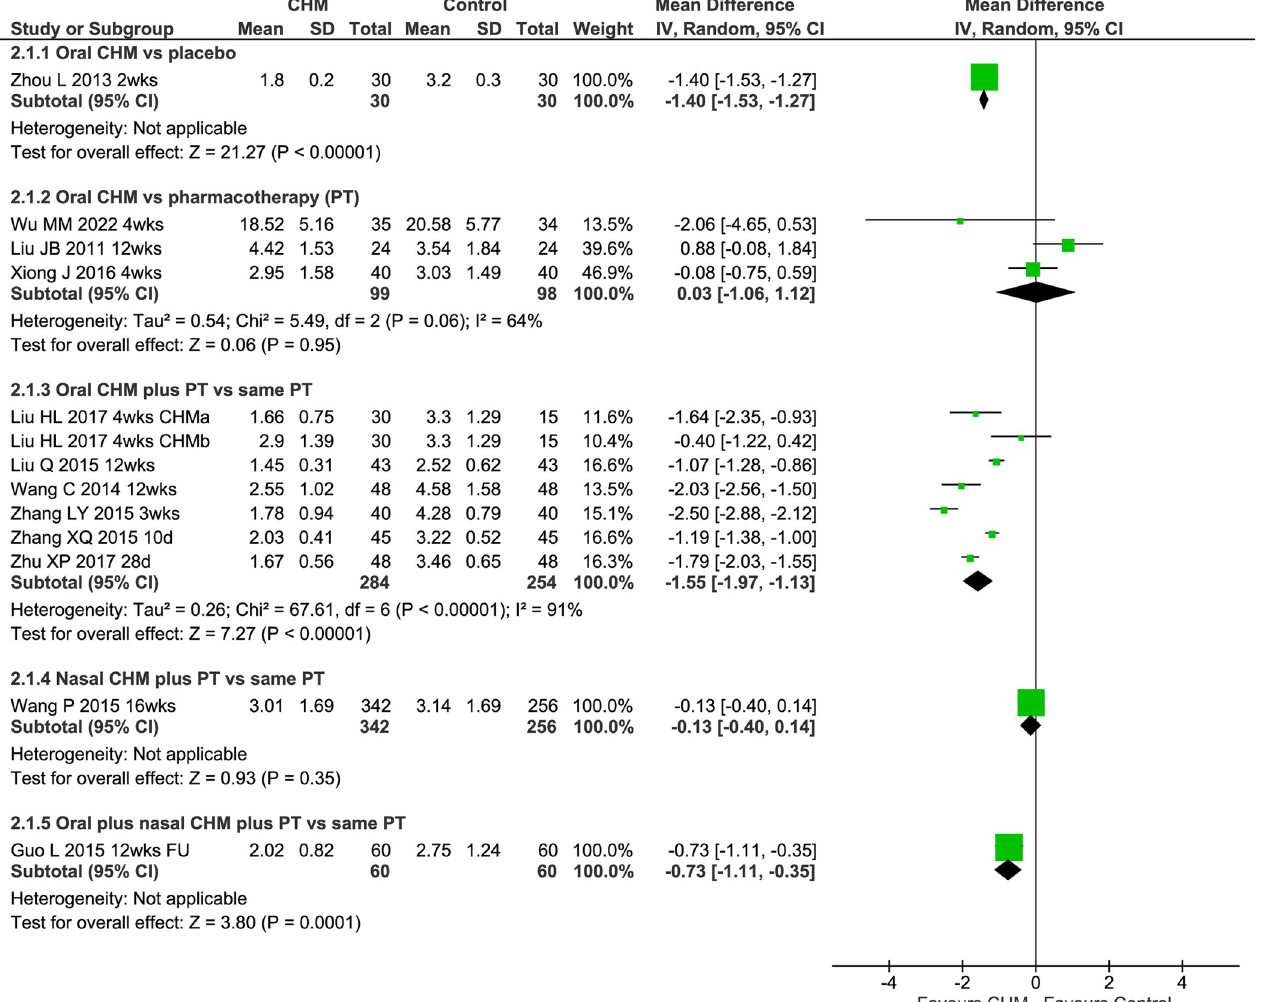
PLOS ONE | https://doi.org/10.1371/journal.pone.0278492 December1,